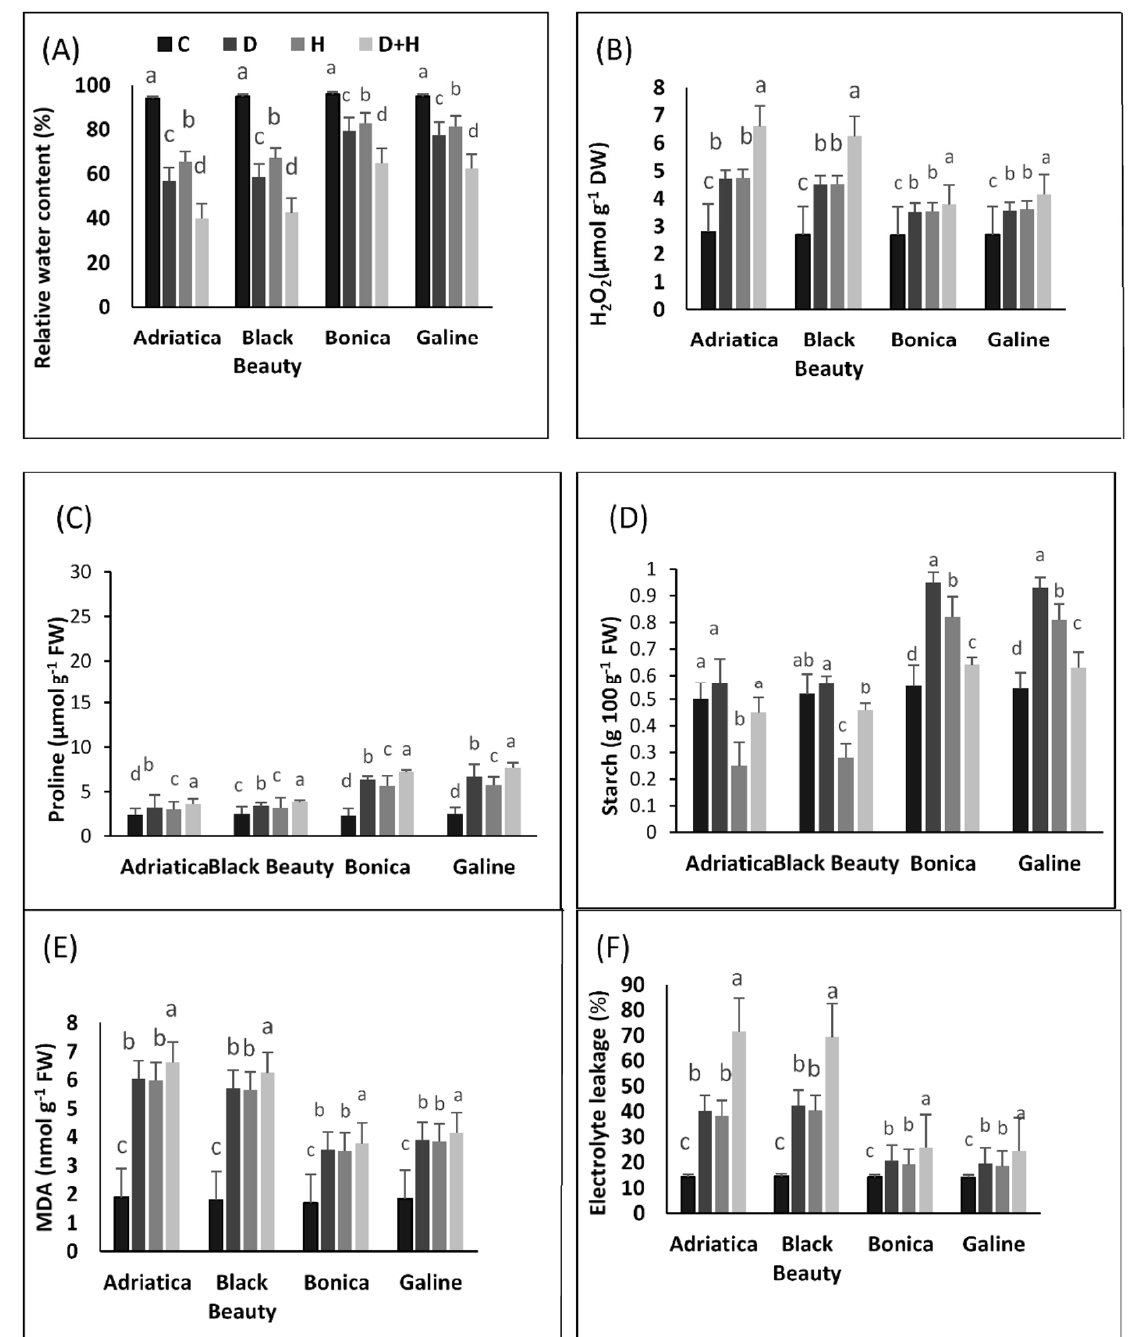
Figure 3. Changes in relative water content (%) ( A ), H 2 O 2 content ( µ mol g − 1 DW) ( B ), leaf proline content ( µ mol g − 1 FW) ( C ), leaf starch content (g 100 g − 1 FW) ( D ), peroxidation of leaf lipid (nmol g − 1 FW) ( E ), and in electrolyte leakage (%) ( F ) of four eggplant cultivars under individual and combined stresses. Data presented are the means ± SE ( n = 5). Significant dissimilarities are shown by different lower-case letters between treatments p ≤ 0.05 based on Tukey’s test. (C, control; H, heat stress; D, drought stress; H + D, heat + drought stresses).